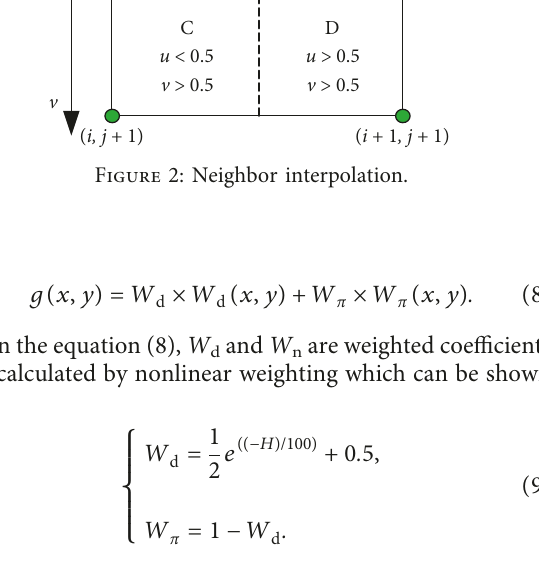
Figure 3: CTSFA calculation of the initial value of displacement.